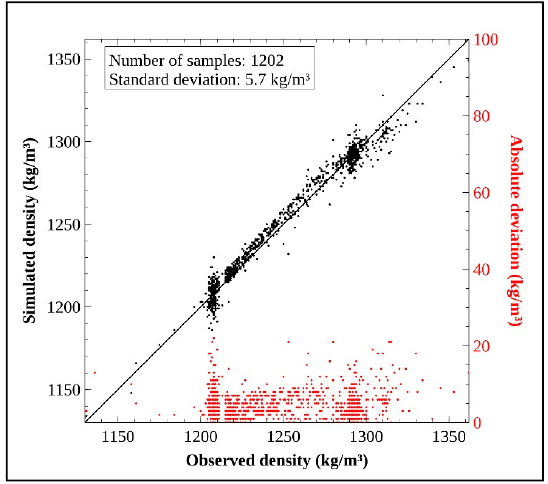
Figure 3. Comparison between observed and simulated densities.